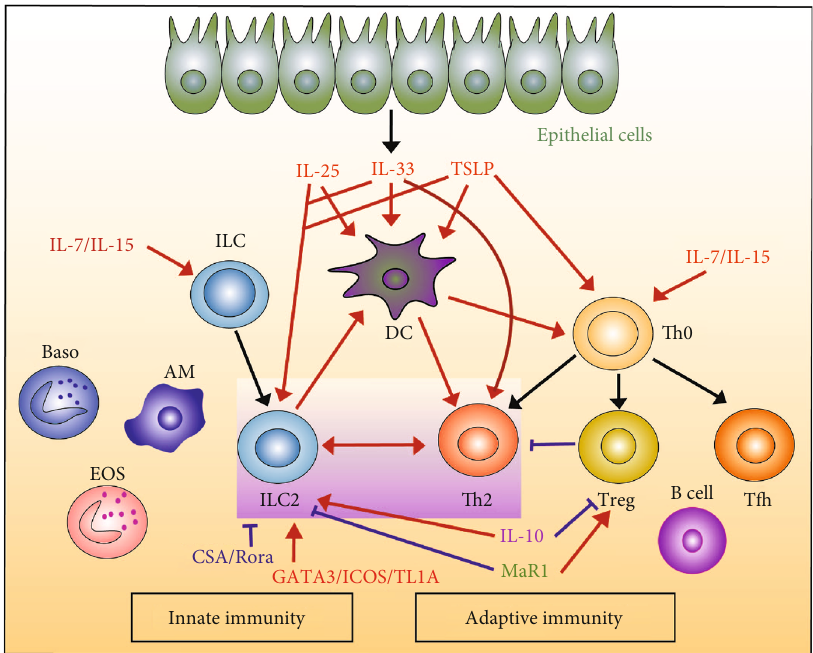
Figure 1: Co-stimulatory factors of ILC2s and CD4 + T cells and their roles in innate and adaptive